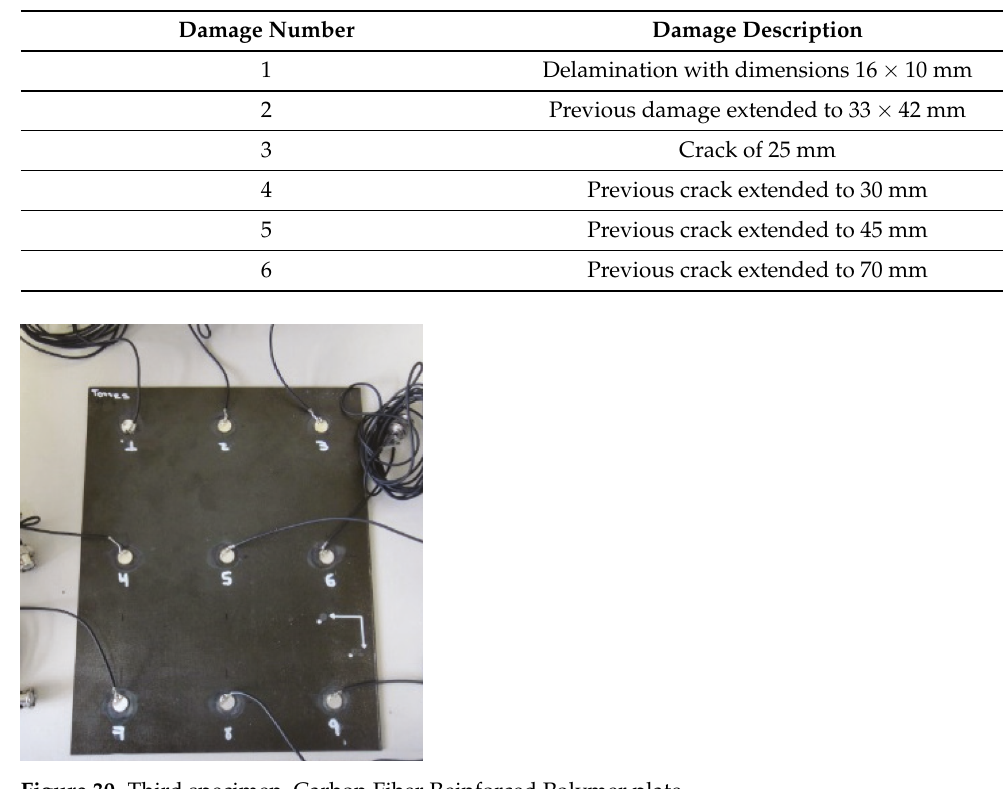
Figure 30. Third specimen, Carbon Fiber Reinforced Polymer